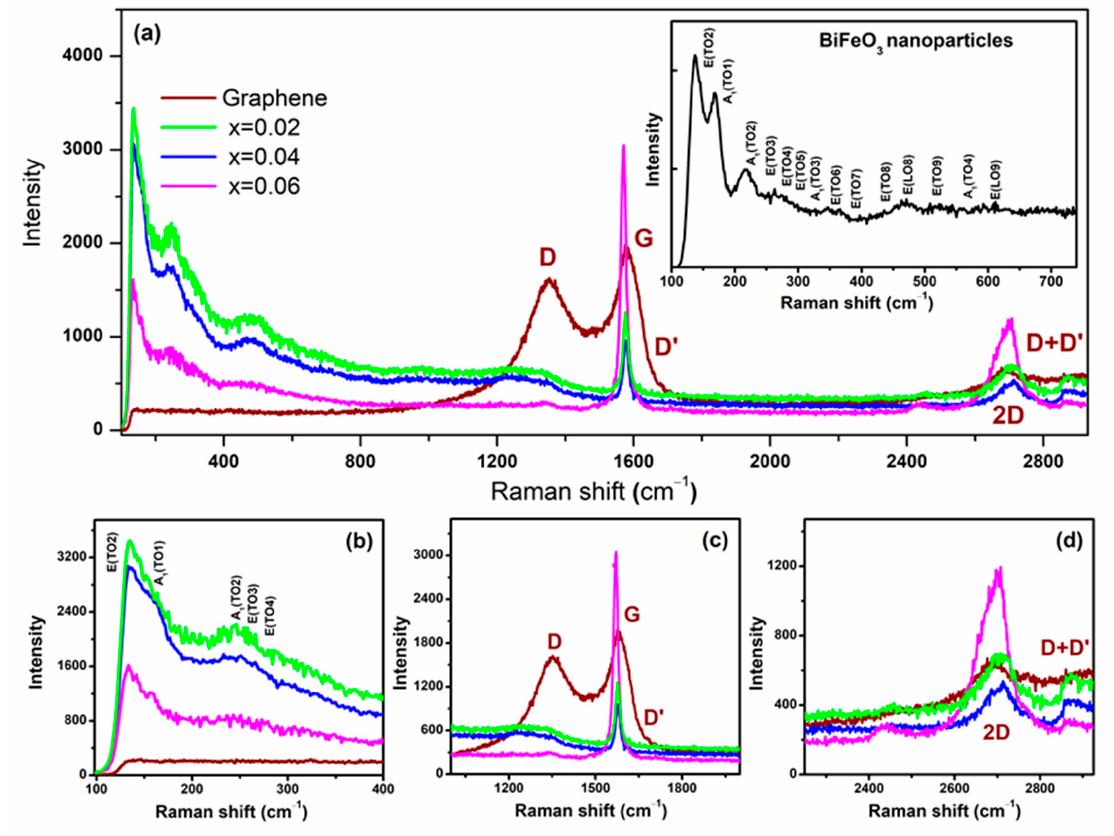
Figure 4. ( a ) Room temperature Raman spectra of [BiFe 1 − x Li x O 3 ]-graphene nanocomposite. The inset of ( a ) shows the Raman spectra of BiFeO 3 nanoparticles. ( b – d ) Magnified Raman Spectra of the [BiFe 1 − x Li x O 3 ]-graphene nanocomposite.